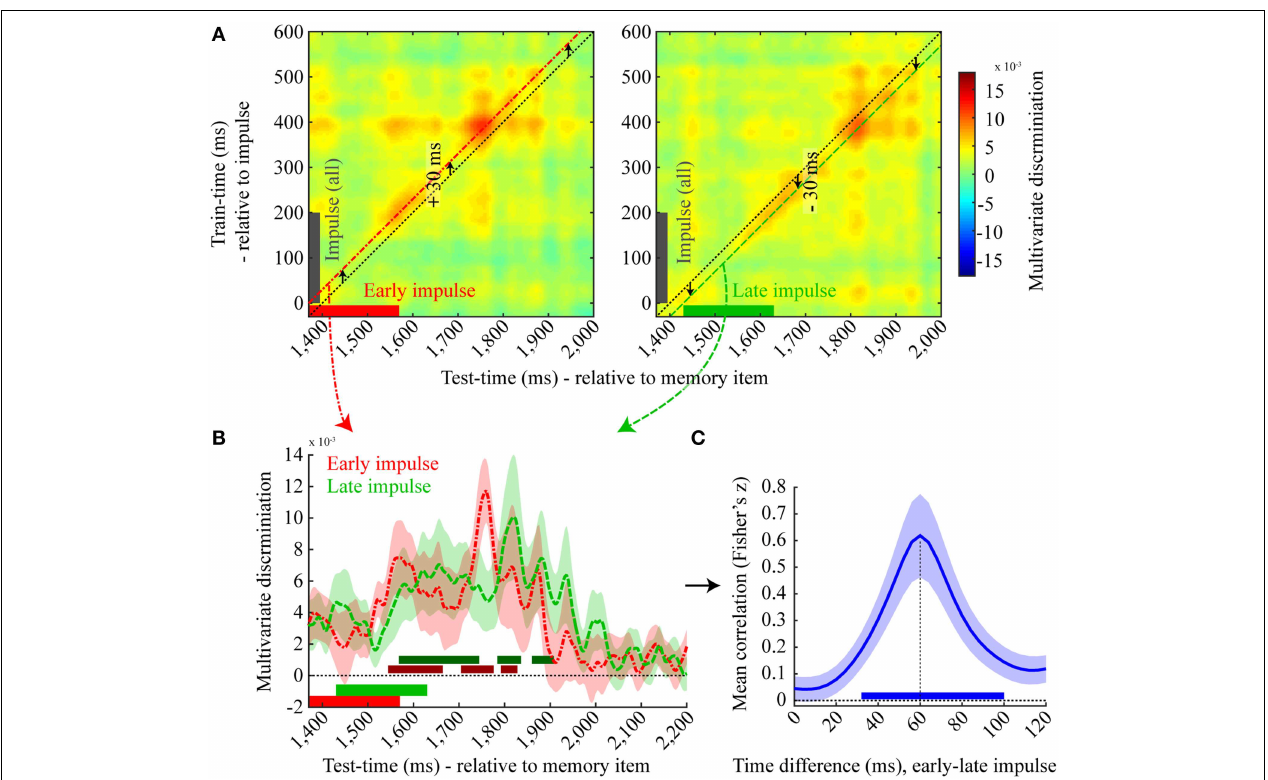
FIGURE 7 | Effect of late impulse onset. (A) Mean discrimination matrices derived from training on all impulse trials, time-locked to impulse onset, and testing separately on early (left, red) and late (right, green) impulse onset trials. The black dotted lines illustrate the multivariate discrimination when tested on the average impulse onset relative to memory item (1400ms) but trained relative to the actual impulse onset (0ms). Discrimination for early onset trials is highest when the training time is shifted by + 30ms (left, red line) and highest for late onset trials when shifted by − 30ms (right, green line). (B) A one dimensional plot of the early (red) and late (green) onset discriminations trained at + 30ms and − 30ms relative to impulse onset, respectively. Significant positive clusters of each onset condition are indicated by bars in a darker shade of the corresponding colors. Error bars are standard deviations of the permuted null distributions. (C) Mean correlations (Fisher’s z) between the decoding time-course for the early and late impulse onset trials as a function of different temporal shifts. Mean correlation peaks at 60ms. The blue bar illustrates the significant positive cluster of correlations. Error bars are standard deviations of the permuted null